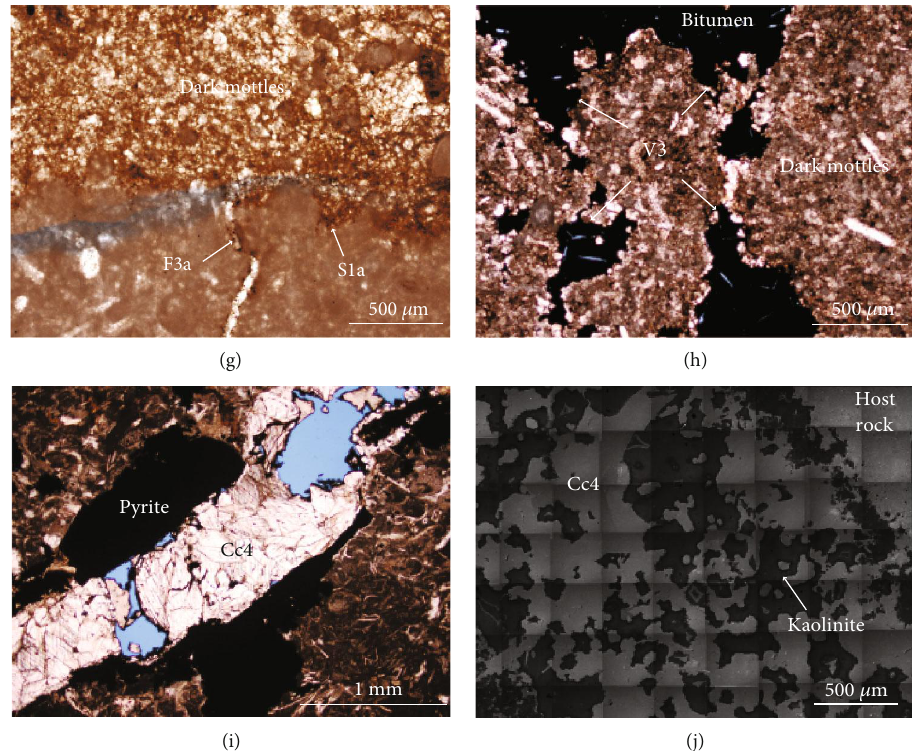
Figure 8: (a, b) Hand specimen of the Yijianfang Formation showing S1a, S1b, and S2 stylolites and V3 and V4 dissolution vugs. (c) Plane light optical photomicrograph showing a V3 lined by Cc3a calcite cement and bitumen. (d) Plane light optical photomicrograph showing a V6 vug fi lled with blocky Cc6. (e, f) Hand specimens and (g) plane light optical photomicrograph of the Yijianfang Formation showing an association between F3a, S1a, and dark mottles. (h) Plane light optical photomicrograph showing V3 vugs occurring within a dark mottle. Bitumen-in fi lled vugs and interparticle porosity within mottle fabrics. (i) Plane light optical photomicrograph showing pyrite mineralization and an F4a fracture enlarged by secondary dissolution. (j) Panchromatic SEM-CL photomosaic showing corroded Cc4 and precipitation of kaolinite into dissolved